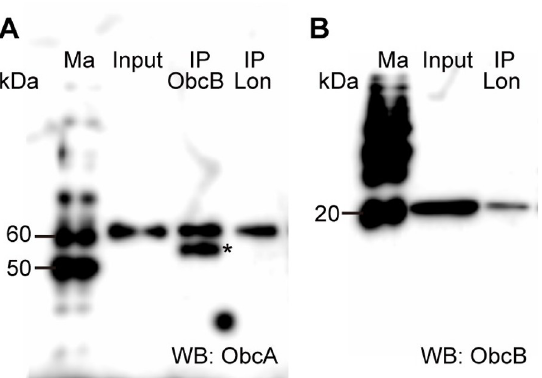
Fig 7. Lon protease interacted with ObcA and ObcB. (A) The ObcA protein was pulled down from the total cell lysate of the wild type strain grown in the early stationary phase using anti-ObcB and anti-Lon antibodies in affinity pulldown experiments. Western blotting was performed using an anti-ObcA antibody to detect ObcA in the immunoprecipitated samples. � denote additional unidentified positive signals. (B) The ObcB protein was detected from the total cell lysate of the wild -ype strain grown in the early stationary phase using an anti-Lon antibody. Ma, Input, IP, and WB denote molecular markers, total lysate of the wild type, immunoprecipitation, and western blotting,